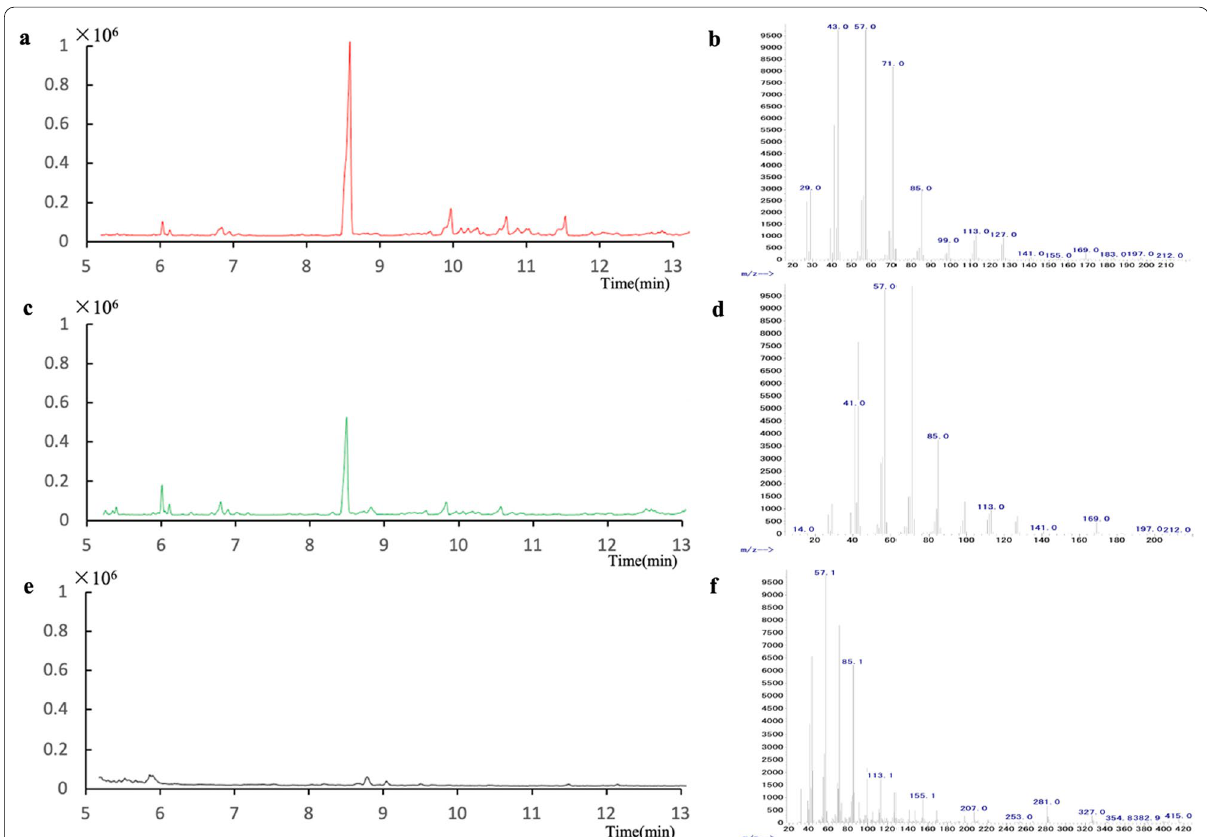
Fig. 6 GC-MS was used to detect the catalytic product of DnFPPS encoding DnFPPS. a FPP-derived farnesane. b Mass spectrum of farnesane. c Samples extracted from the in vitro reaction mixture containing purified DnFPPS. d Mass spectrum of the 8.67-min peak in c . e A sample extracted from an in vitro reaction mixture containing products from a mock-transformant E. coli mock-purification protocol containing the expression vector pET-28a. f Mass spectrum of the 8.85-min peak in